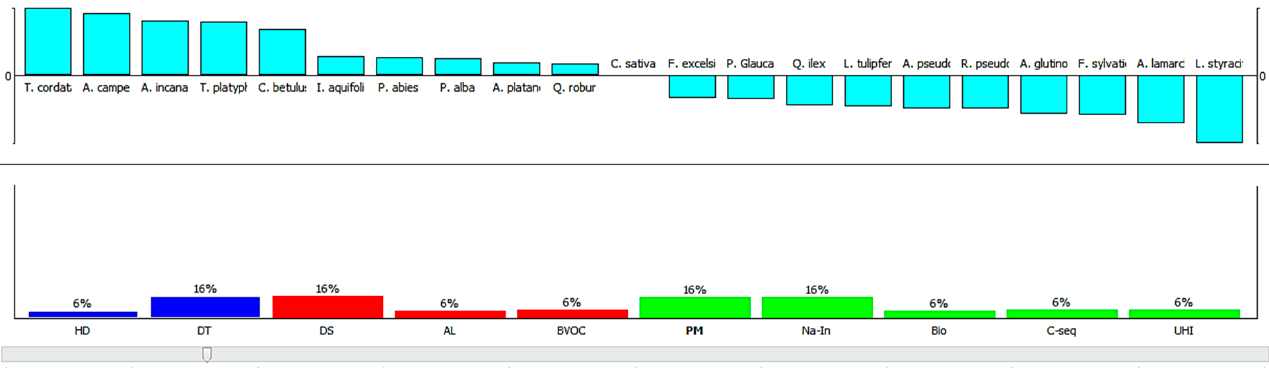
Figure 3. Ranking of plant species shown in the upper part of the bar chart according to scenario (S2) PM mitigation and environmental adaptability. The lower part of the bar chart shows an equally high importance for hardiness, drought tolerance (dark blue bars), disease susceptibility (red bar), PM mitigation, and native-invasive (green bars). The criteria including allergenicity, BVOC emissions (red bars), supporting biodiversity, net carbon sequestration, and reducing urban heat island effect (green bars) are adjusted as having low importance. Plant species are ordered from best to worst. (For an interpretation of the references to color in this figure legend, the reader is referred to the web version of this article.)